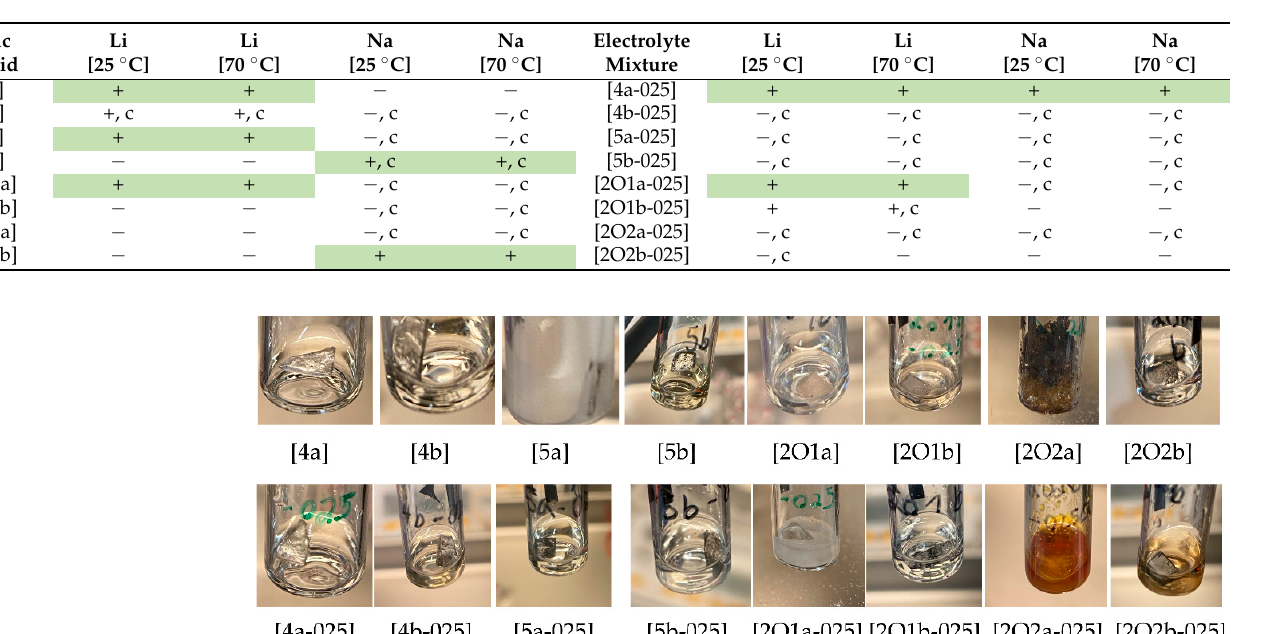
Table 2. Compatibility with alkali metals within two weeks (visible degradation). Following signs are used: “+”: metal remains stable without visible degradation; “c”: electrolyte with change of color; “ − ”: metal with surface modification and/or strong electrolyte reaction. Recognized changes are only visible modifications of the metal and/or liquid solution.